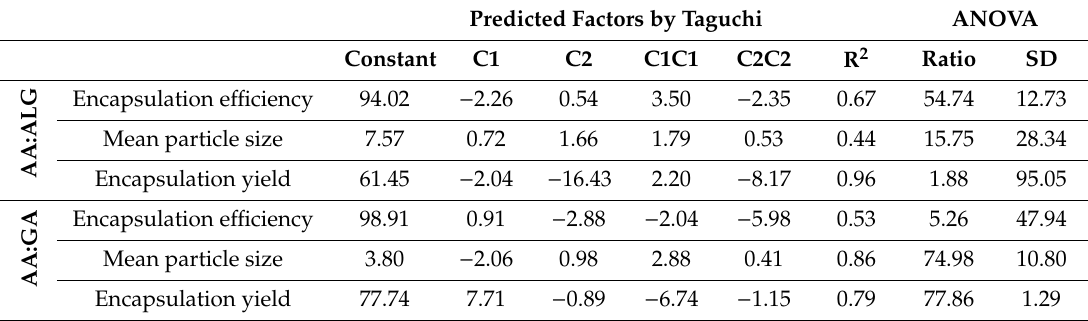
Table 3. Regression model predicted coe ffi cients and ANOVA analysis for the AA encapsulation employing ALG and GA as wall polymers. The acronyms C1 and C2 correspond to coe ffi cients of responses for AA:polymer ratio and total solid dispersed respectively.